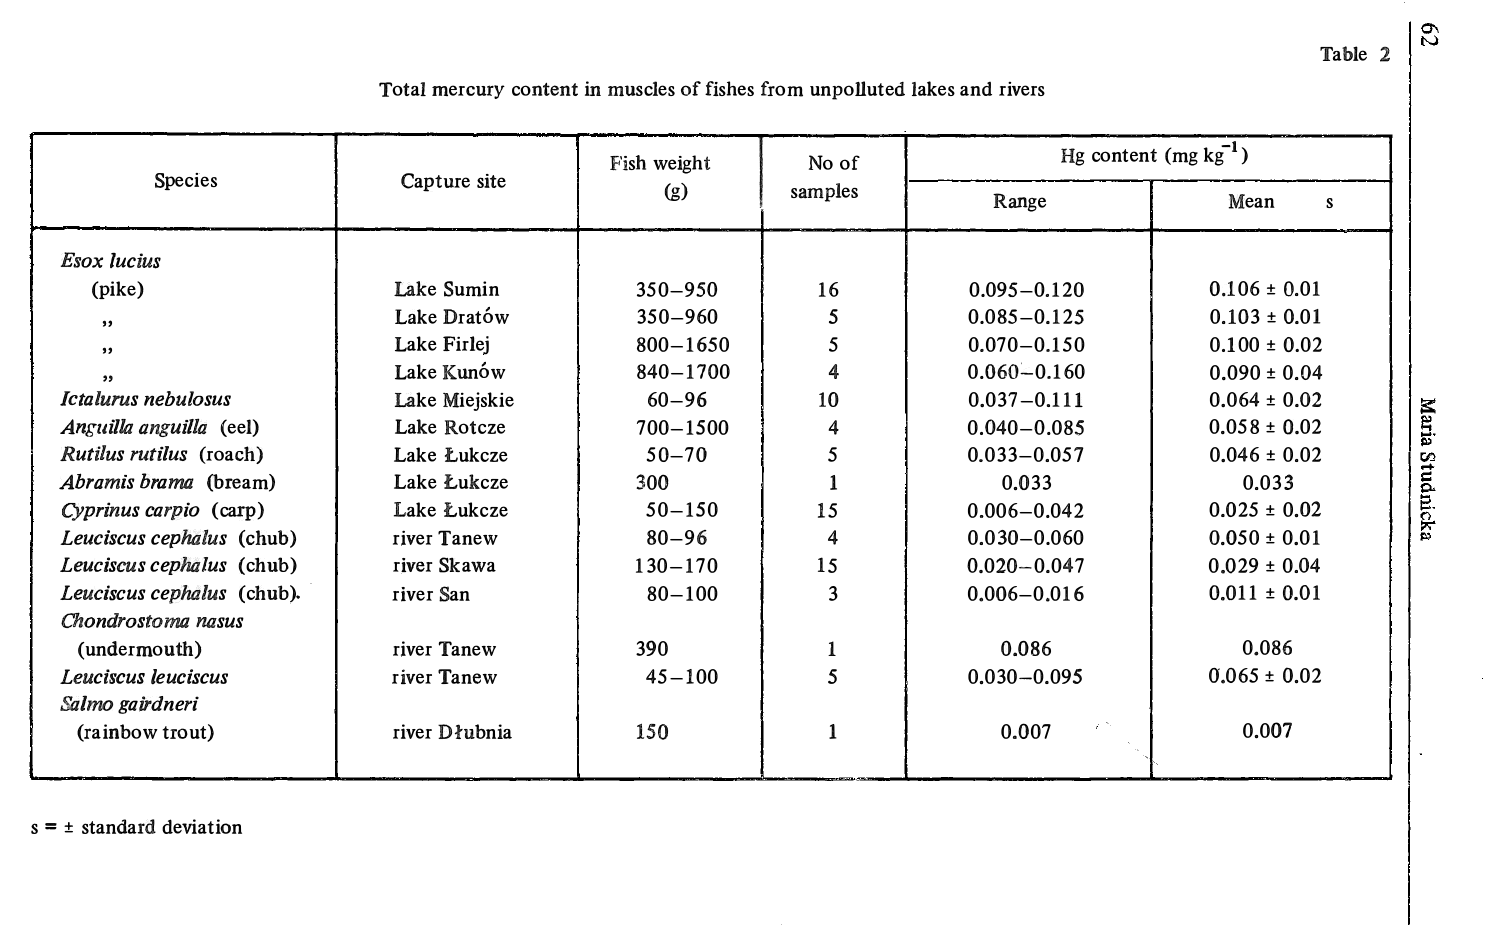
Total mercury content in muscles of fishes from unpolluted lakes and rivers I Fish weight Capture